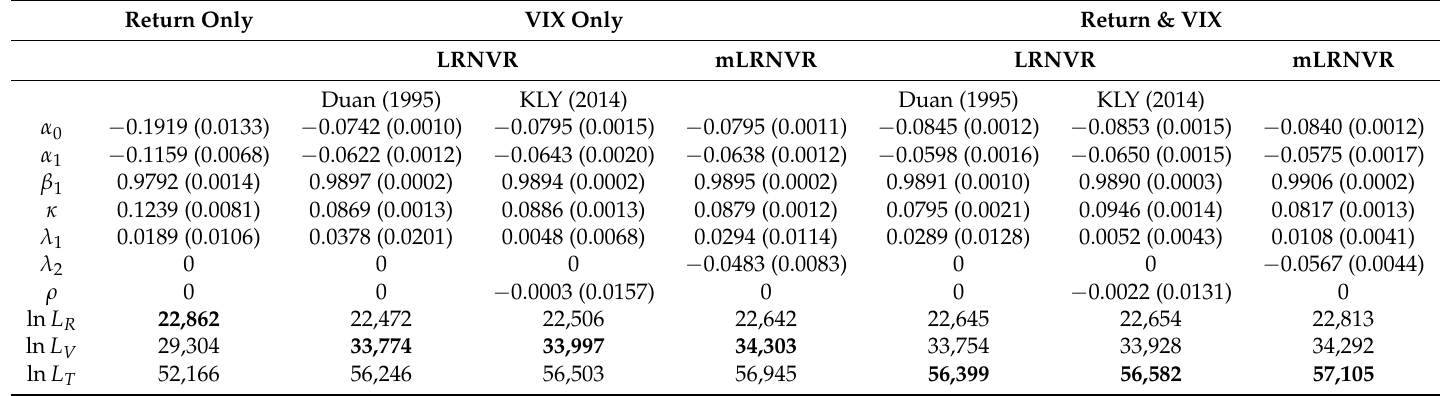
Table 4. Maximum likelihood estimates of EGARCH(1,1) model using returns data only, VIX data only or both returns and VIX data. The bold values indicate the log-likelihood value which is being maximized. The standard errors are provided in parentheses. We use a sample of 6928 daily data for the model